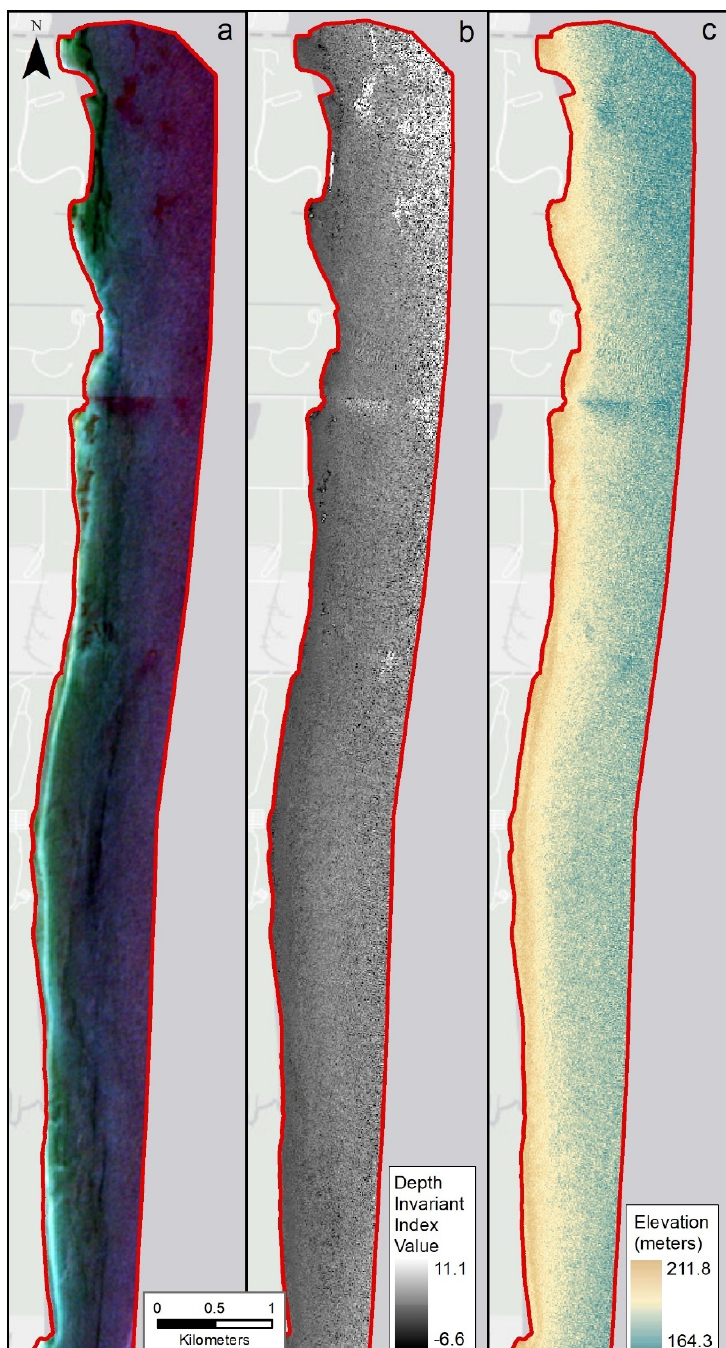
Figure 3. Satellite data products: ( a ) multispectral (bottom of atmosphere) reflectance, ( b ) Depth Invariant Index, and ( c ) Satellite-Derived Bathymetry.